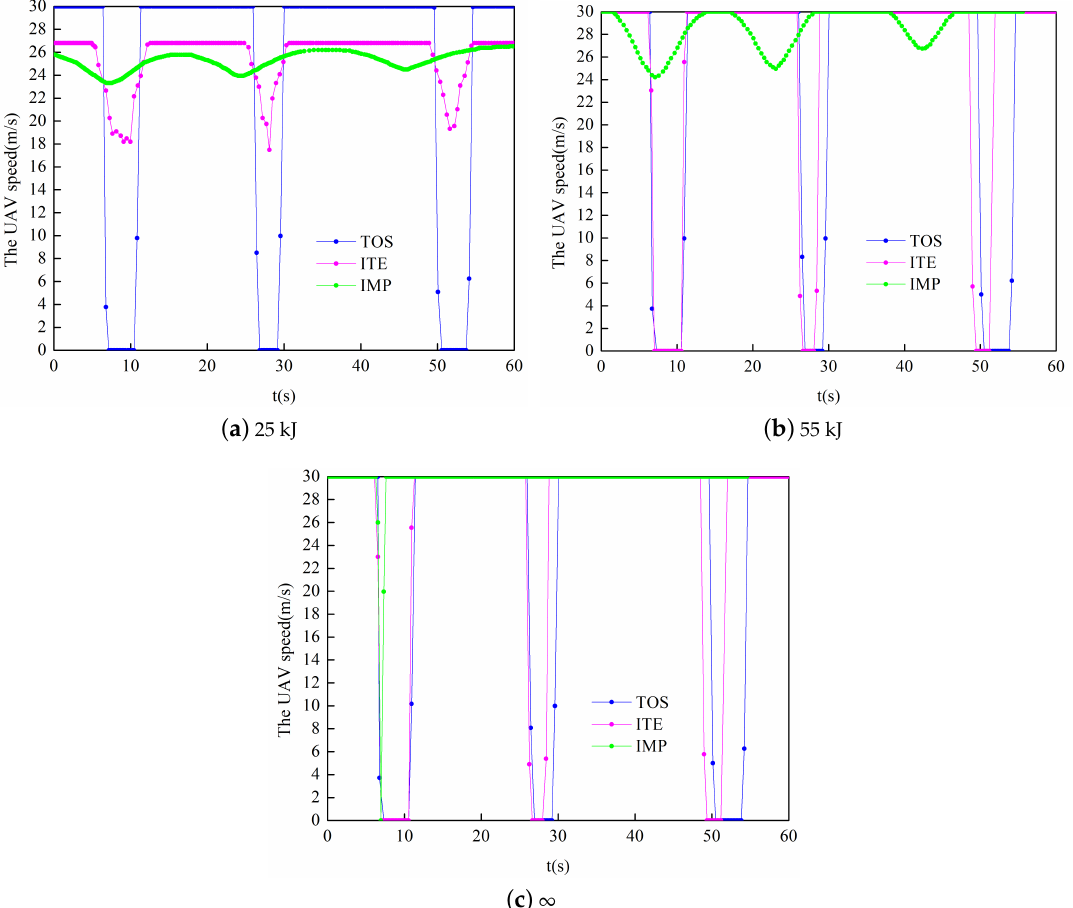
Figure 7. According to different energy constraints, the speed comparison of